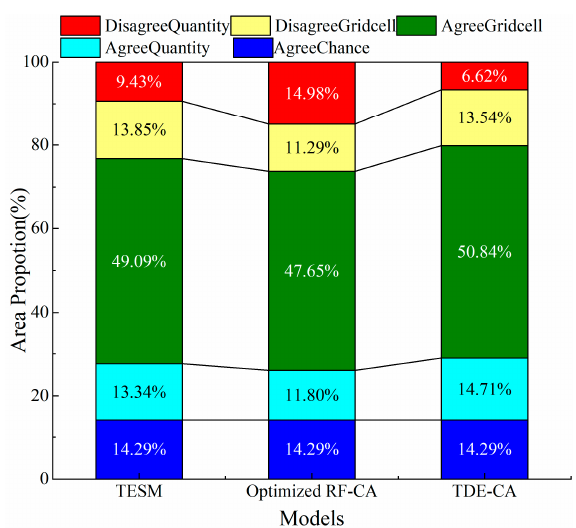
Figure 7. The comparison of the TDE-CA and its sub-models in agreement and disagreement.